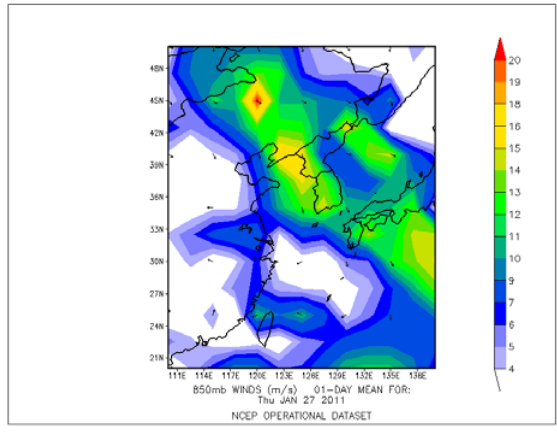
Figure 7. Day mean wind speed and wind vector at 850hPa. Data from NCEP daily analysis product